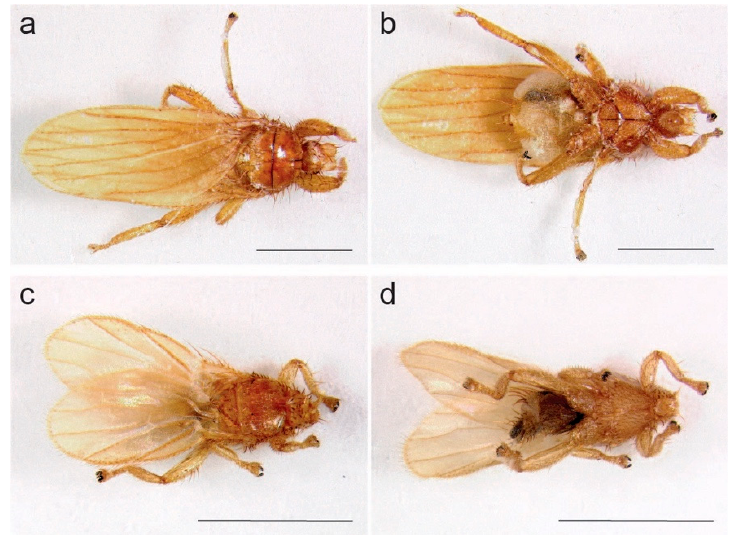
Figure 2. Images of streblid bat flies from México and Uganda. ( a,b ) The Méxican specimen ( a : dorsal, b : ventral; 2.5× magnification and a patch size of 16) was collected from a Parnell’s mustached bat ( Pternotus parnellii Gray, 1843) at Estación Científica Las Joyas, Sierra de Manantlán, Jalisco, on 17 January, 2018. ( c,d ) the Ugandan specimen ( c : dorsal, d : ventral; 4.0× magnification and a patch size of 18) was collected from a Noack’s roundleaf bat ( Hipposideros ruber Noack, 1893) at Ngogo, Kamwenge District, on 1 July, 2017. Scale bars = 1 mm.